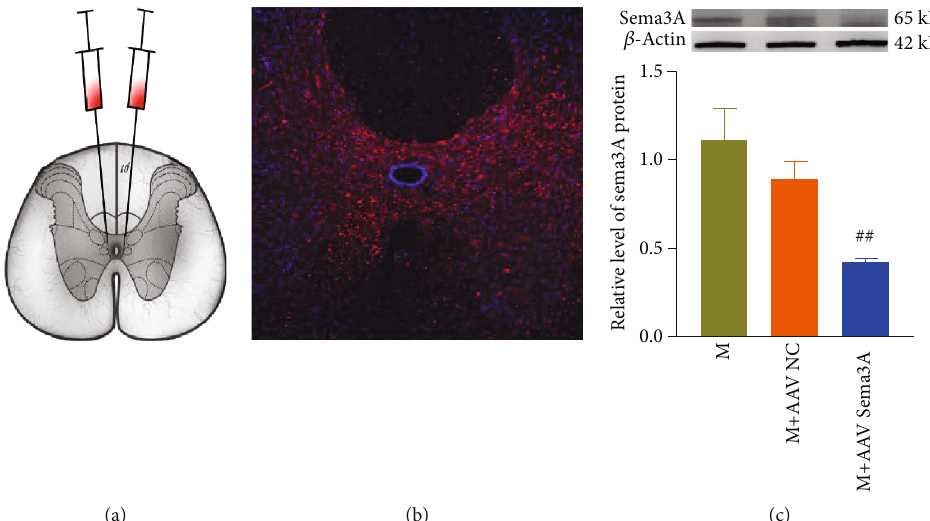
Figure 6: The expression of Sema3A around the central tube of the spinal cord is decreased after knockdown Sema3A. (a) Schematic diagram of virus injection. (b) The microscopic representative diagram of the T10 expression at 4 weeks after virus injection. (c) The quantitative diagram represents bands of Sema3A Western blotting in the T10 spinal cord at 4 weeks after virus injection, n = 3 , compared with the SCI group, ## P < 0 : 01 . All data are presented as the mean ± SEM